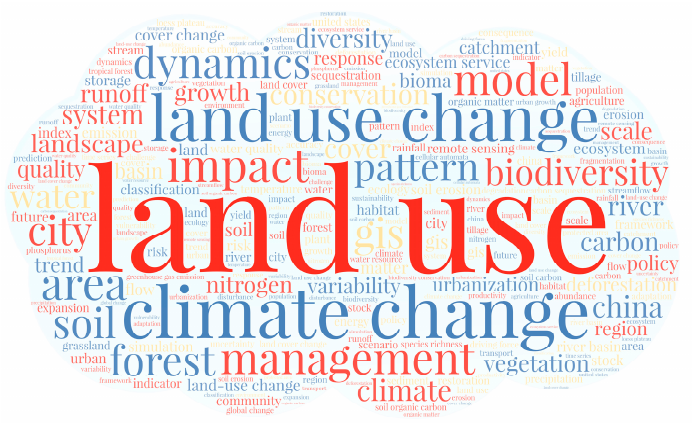
Figure 7. Word cloud of the most frequently used keywords in selected articles.